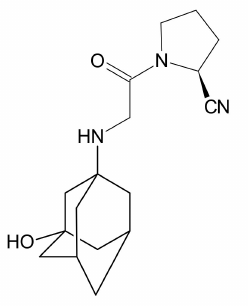
Figure 1. Chemical structure of vildagliptin (( 2S )-1-{[(3-hydroxytricyclo[3.3.1.13,7]-decan-1-